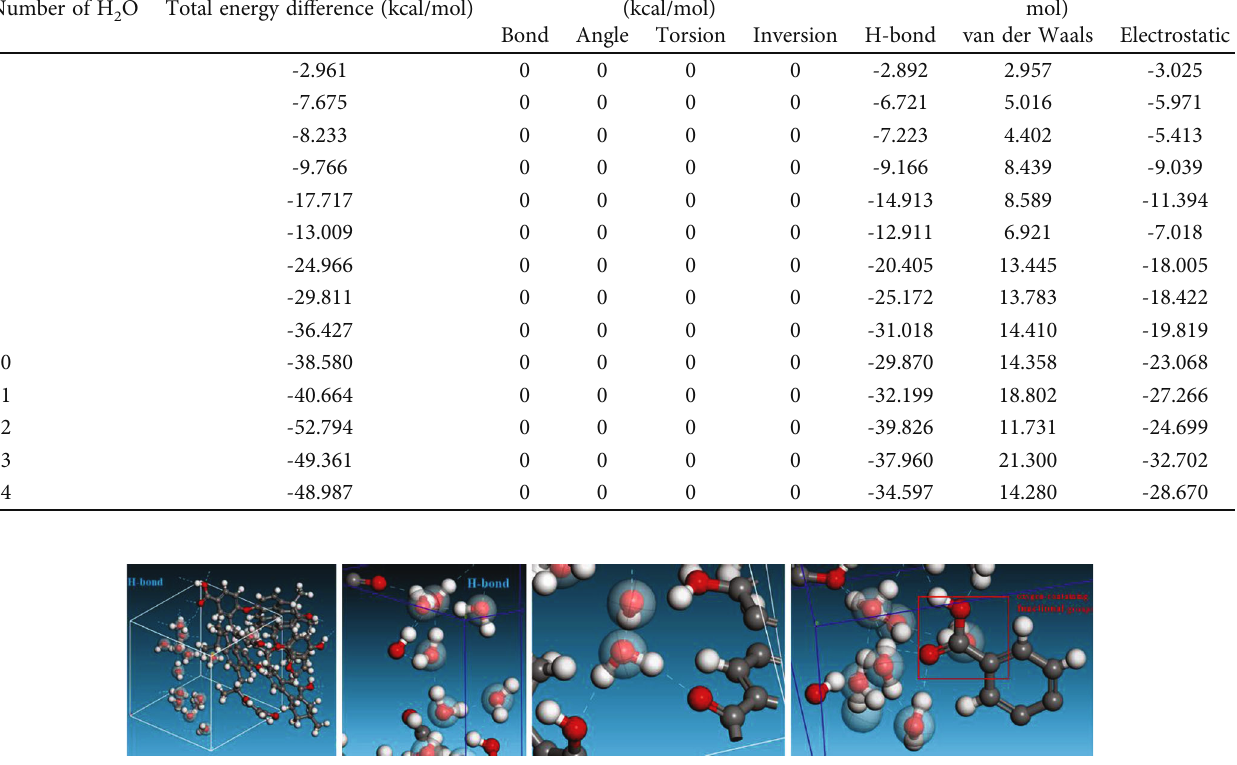
Table 3: Energy changes of the long- fl ame coal molecule before and after adsorption of di ff erent numbers of H O Number of H 2